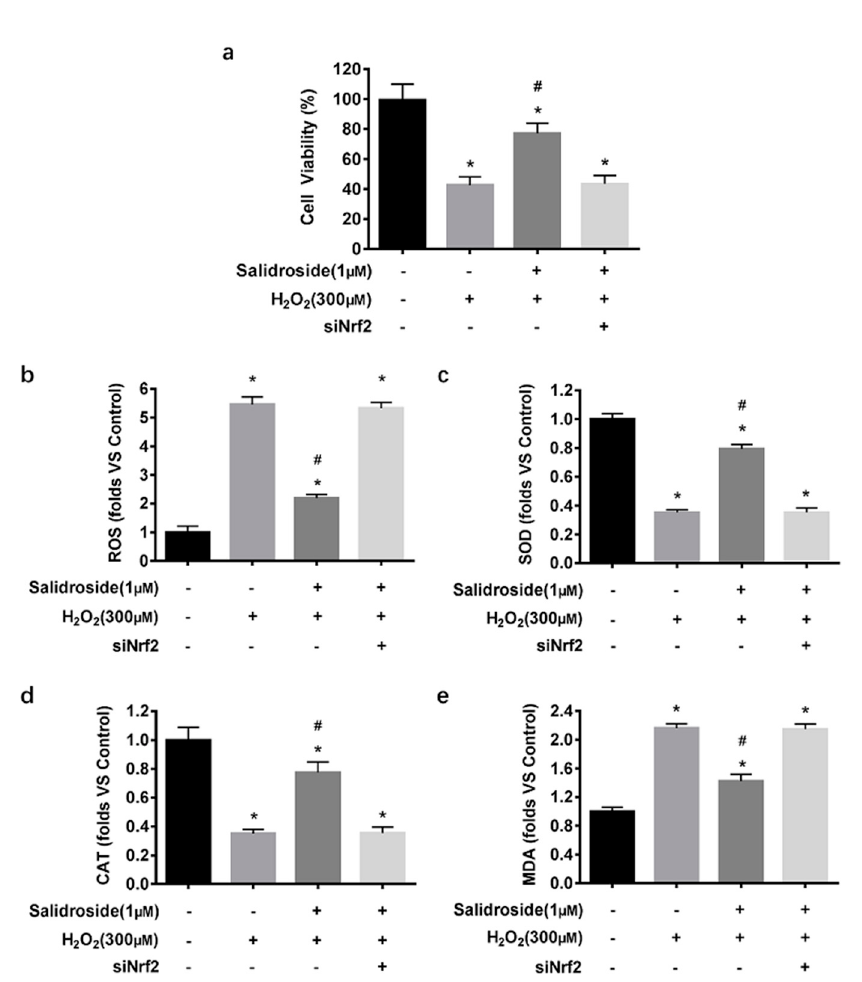
Figure 7. Effects of SAL on H 2 O 2 -induced cytotoxicity and oxidative stress in Nrf2 knockdown HUVECs. ( a ) Cell viability analysis. HUVECs were preincubated with or without Nrf2 siRNA, then treated with 1 μ M SAL for 24 h before being treated with 300 μ M H 2 O 2 for another 24 h, or 300 μ M H 2 O 2 for 24 h. Cell viability was determined using MTT assay. ( b – e ) HUVECs were preincubated with or without Nrf2 siRNA, then treated with 300 μ M H 2 O 2 for 4 h, or 1 μ M SAL for 24 h followed by 300 μ M H 2 O 2 for an additional 4 h. ( b ) Intercellular ROS levels: Intercellular ROS levels were determined by DCF fluorescence. After various treatment, the cells were stained with 10 μ M DCFH-DA in serum free medium for 30 min in the dark. Fluorescence intensity was recorded using a Synergy TM 4 Multi-Mode Microplate Reader. ( c – e ) SOD, CAT activities, and MDA content: SOD, CAT activities, and MDA content were measured using respective assay kits. Data are presented as mean ± SD values of three independent experiments. * p < 0.05 vs. control. # p < 0.05 vs. H 2 O 2 -treated HUVECs.